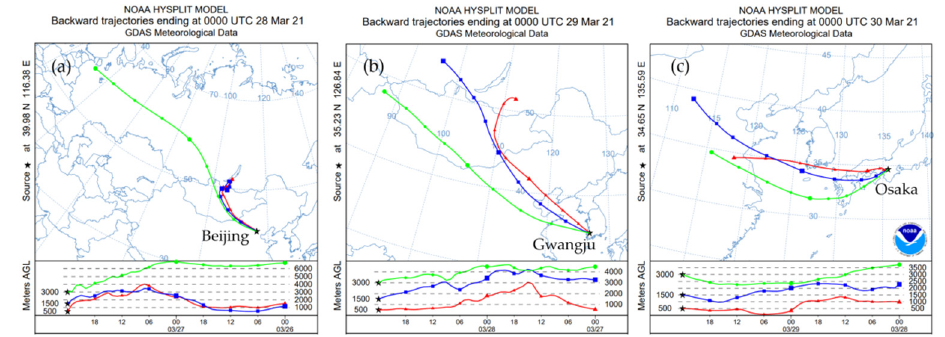
Figure 6. Backward trajectories from HYSPLIT model at different locations during 28 to 30 March 2021: ( a ) 48 h back trajectories ending at Beijing on 28 March; ( b ) 48 h back trajectories ending at Gwangju on 29 March; ( c ) 48 h back trajectories ending at Osaka on 30 March.